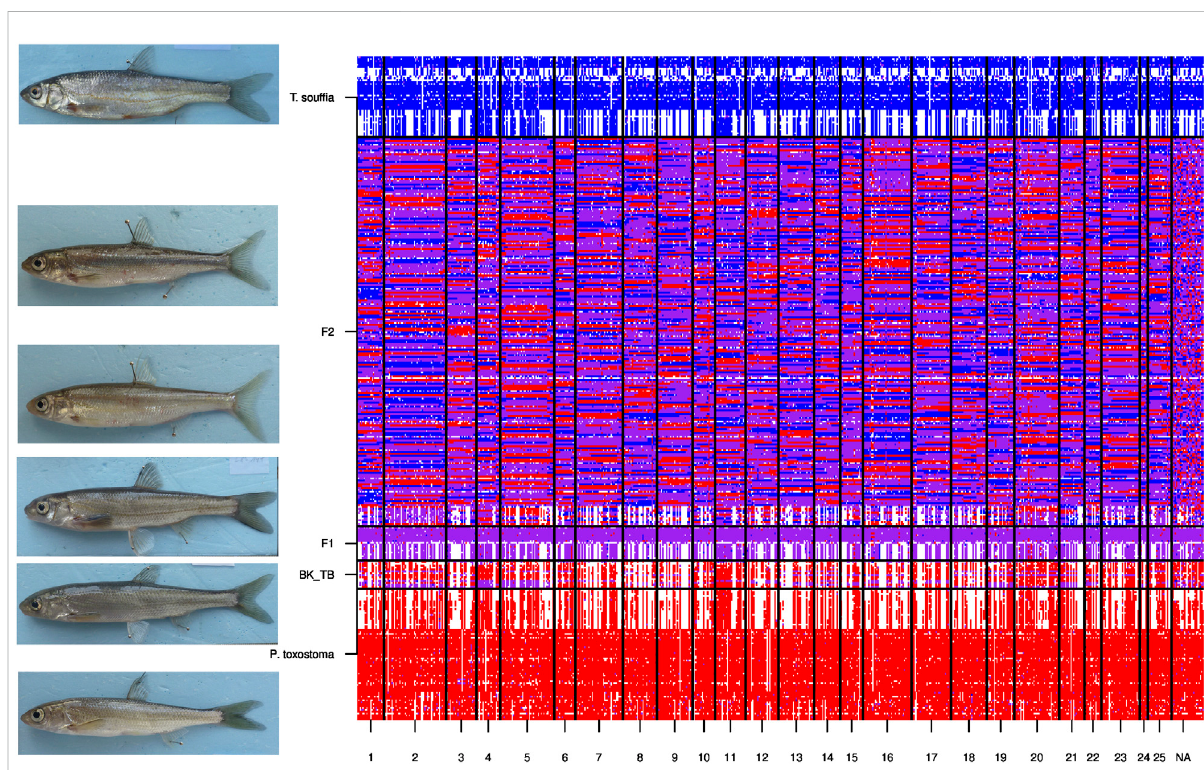
FIGURE 5 Genetic architecture of nuclear DNA SNPs for hybrid and parental populations. Lines represent specimens belonging to the six groups: respectivelyfrombottomtotop: P.toxostoma ,Backcrosses( P.Toxostoma XF1-hybrids),F1-hybrids,F2-hybridsand T.souf fi a .Columnscorrespond to the 641 discriminants SNPs following chromosoms numbers (1 to 25, NA for not attributed). Each intersection line X column corresponds to a genotype.Thisgenotypeisindicatedinredforhomozygous P.toxostoma ,inblueforhomozygous T.souf fi a ,inpurpleforheterozygous,andin white for missing